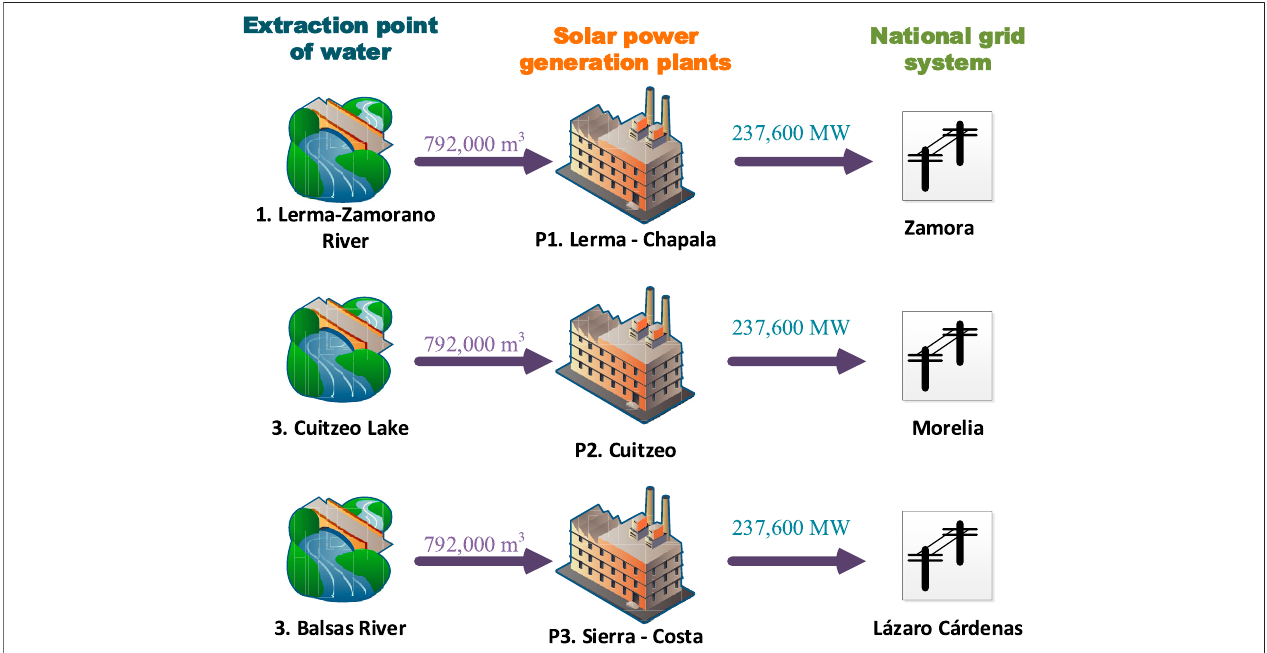
FIGURE3| OptimaldistributionofscenarioA,fortheinstallationofsolarconcentrationplantsforelectricpowergenerationforcased(24 hofoperationwith19 hof thermal storage).